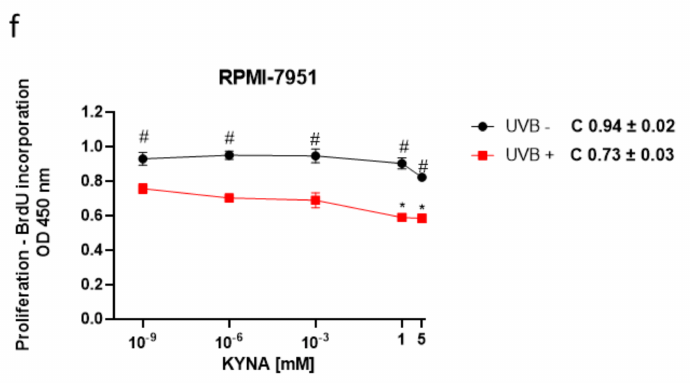
Figure 1. The effect of UVB on the proliferation of melanoma A375 ( a , b ), SK-MEL-3 ( c , d ), and RPMI-7951 ( e , f ) cells exposed to KYN and KYNA. Melanoma A375, SK-MEL-3, and RPMI-7951 cells were exposed to UVB (UVB+) and then to culture medium (control, C) or serial dilutions of KYN and KYNA (10 − 9 , 10 − 6 , 10 − 3 , 1, and 5 mM) for 24 h. Similarly, antiproliferative activity of KYN and KYNA was studied in melanoma cells under standard conditions (UVB − ). The effect of UVB and tested substances on proliferation (DNA synthesis) of melanoma cells was assessed by the BrdU Assay. Data represent the mean value ± SEM of eight independent experiments. Values significant (*) in comparison with the appropriate control (UVB − or UVB+) with p < 0.05 (one-way ANOVA with Tukey’s post hoc test). Values significant (#) UVB − vs. UVB+ with p < 0.05 (unpaired t -test). The effect of KYN and KYNA on BrdU incorporation in A375 and RPMI-7951 cells under standard conditions has been previously published in [11].